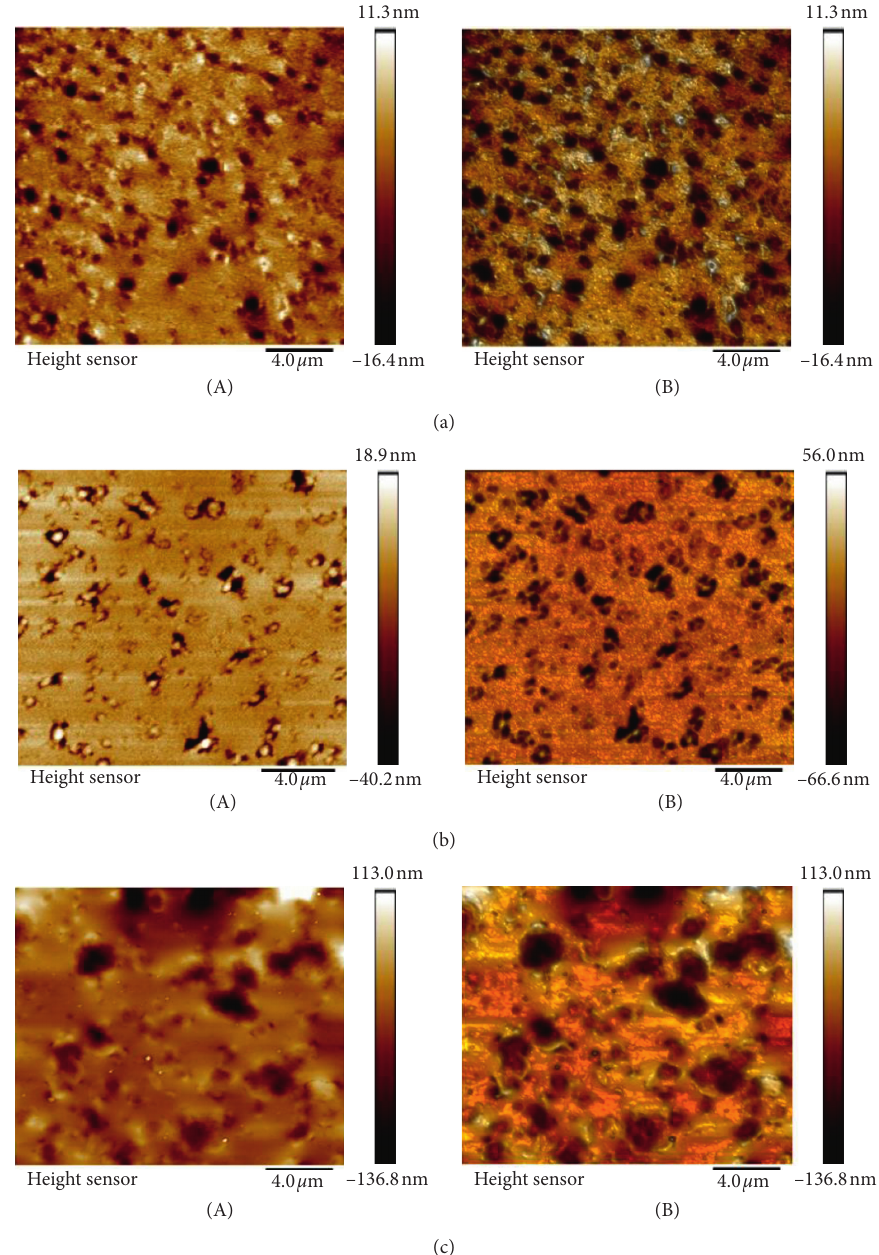
Figure 12: AFM images of asphalt binders of rubber asphalt binders. (A) Topographical image. (B) Phase image. (a) Rubberized Control binders, Ra � 2.60nm. (A) Topographical image. (B) Phase image. (b) Rubberized binders with Tego Addibit, Ra � 5.62nm. (A) Topo- graphical image. (B) Phase image. (c) Rubberized binders with Tego XP, Ra �